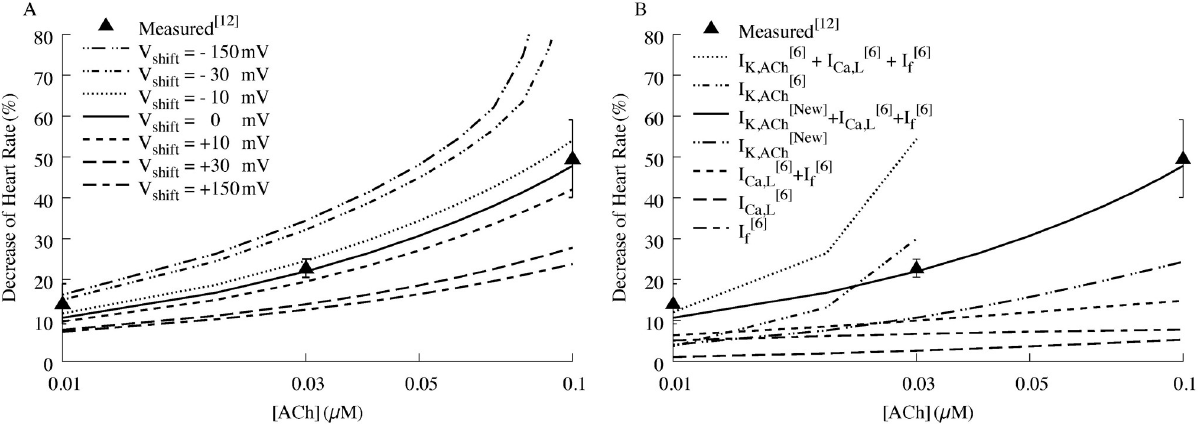
Fig 5. Comparison of simulated to measured ACh concentration-heart rate response in humans. (A) Concentration-heart rate response to the effect of variable M2R voltage sensitivity. Negative voltage shifts accentuate the response of ACh, while positive shifts blunt the heart rate slowing induced by ACh. (B), The individual contributions of ACh-sensitive currents to the measured concentration-heart rate response. Our current model that (new), together with formulations for the ACh-sensitive currents I Ca,L and I f from Fabbri incorporates the voltage-sensitivity of the M2R into I K ,ACh et al [6] provides the best fit to the measured data. I contributes to about 50% of the heart rate response at 0.03 μ M ACh and contributes a greater K ,ACh proportion to heart rate slowing at higher ACh